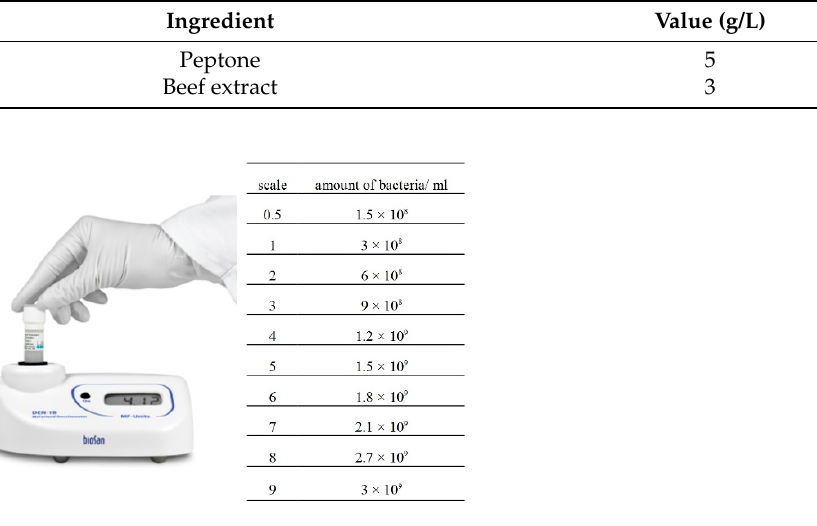
Figure 3. McFarland scale. Table 3. The composition of Nutrient Broth